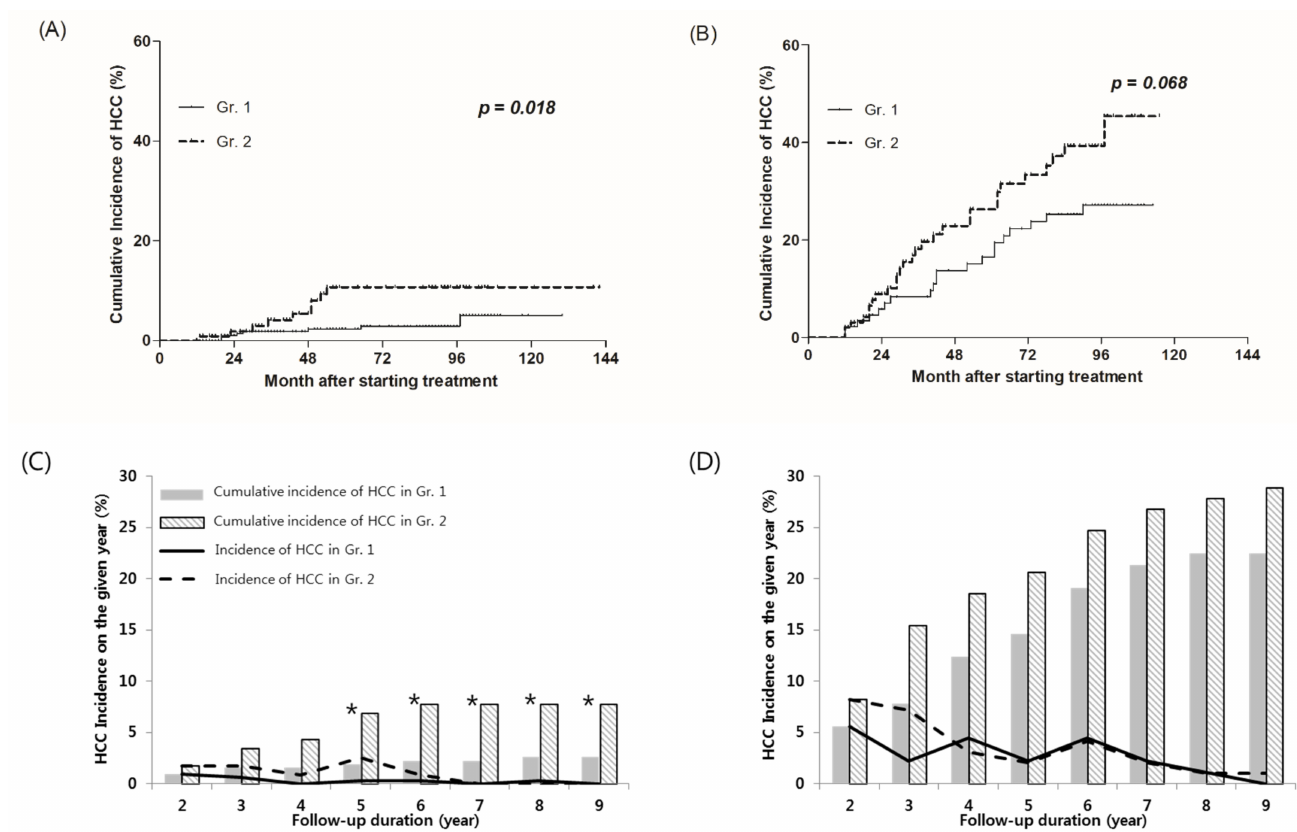
Figure 3. HCC cumulative incidence according to early on-treatment ALT normalization. ( A , C ) Patients without liver cirrhosis at baseline, and ( B , D ) patients with liver cirrhosis at baseline. HCC, hepatocellular carcinoma. * Denote the columns at the time when significant differences were